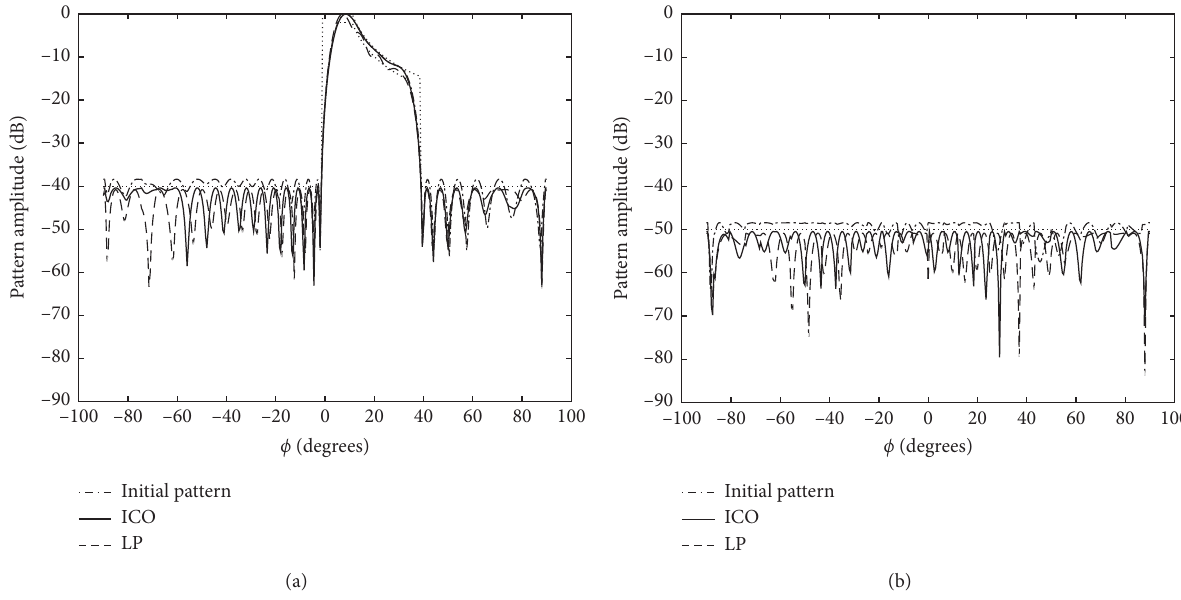
Figure 10: Cosecant-square-shaped beam synthesis. (a) Copolarization component E